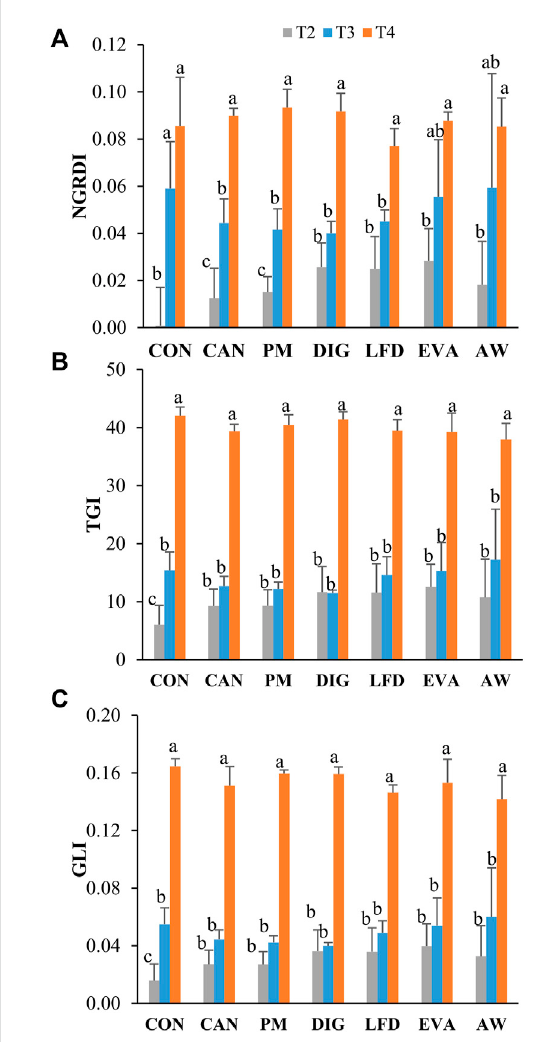
FIGURE 3 ValuesofNGRDI (A) ,TGI (B) andGLI (C) observedatsampling moments T2 (9 July 2020), T3 (18 August 2020) and T4 (22 September 2020). The lowercase letters refer to the statistical pig manure; DIG, digestate; LFD = liquid fraction of digestate, EVA, evaporator concentrate; AW, ammonia water.